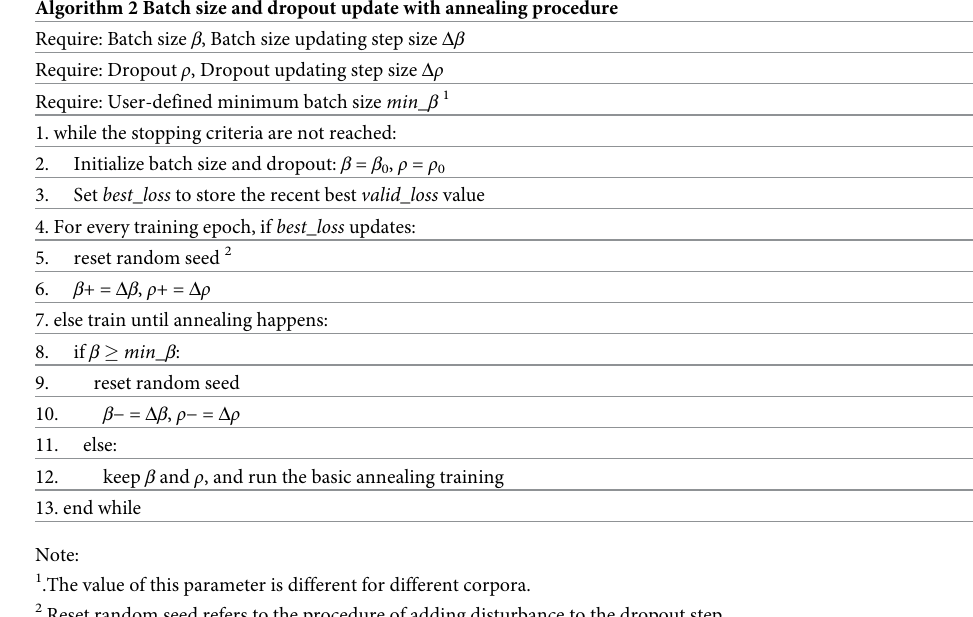
Table 4. The pseudocode of the gradient batch training algorithm. Algorithm 2 Batch size and dropout update with annealing